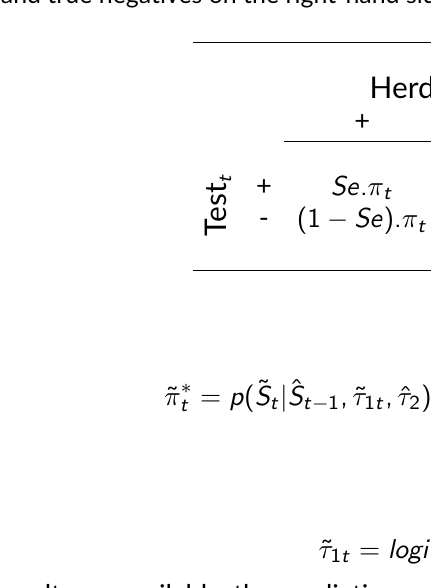
Table 1 – Probability of test result by herd status. Cells on the first row are test positive herds with true positives on the left-hand side and false positives on the right-hand side. Cells on the second row are test negative herds with false negatives on the left-hand side and true negatives on the right-hand